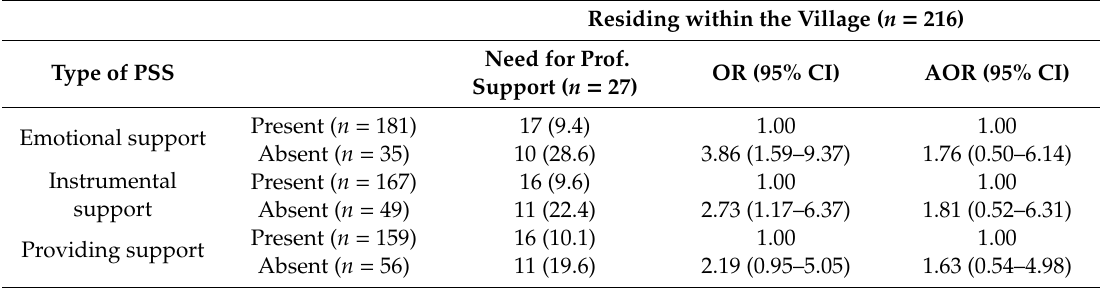
Residing within the Village ( n = 216)